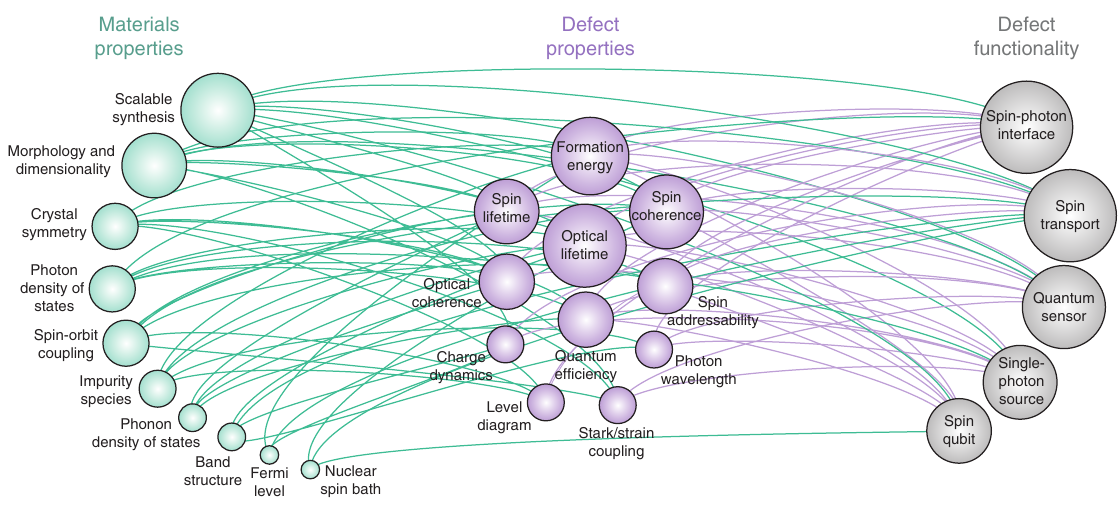
Figure 3: The functionality of a defect for quantum science applications depends in complex ways on the defect’s propeties, which are in turn related to the fundamental properties of the host material and the defect’s composition. Each application requires a different set of